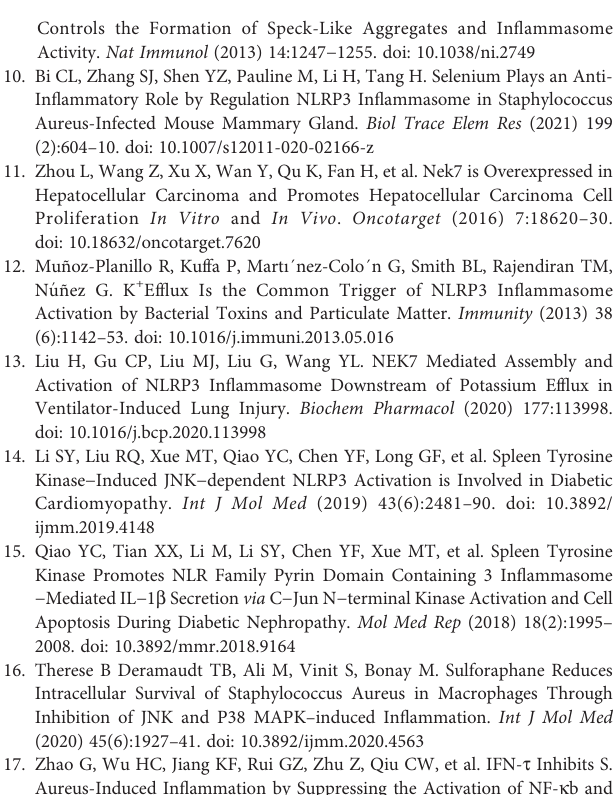
Supplementary Figure 1 | JNK and Syk activated the NLRP3 in fl ammasome upon S. aureus infection in PECs. PECs pretreated with or without JNK inhibitor at the fi nal concentration of 20 m mol/L or Syk inhibitor at the fi nal concentration of 1 m mol/L for 2 h followed by S. aureus infecton (MOI of 1) for 24 h. (A) The mRNA expression levels of caspase-1 , Il-1 b were quanti fi ed by RT-PCR. (B) The protein levels ofcaspase-1, p20, pro-IL-1 b andmIL-1 b wereexaminedby western blotand analyzed by relative densitometric quanti fi cation. (C) Immuno fl uorescence imaged endogenous ASC specks. Cells were fi xed and stained for ASC (Green), DAPI (Blue). (Scale bar: 100 µm.) (D) The mRNA expression levels of caspase-1 , Il-1 b were examined by RT-PCR. (E) The protein expression levels of caspase-1, p20, pro-IL-1 b and mIL-1 b were examined by western blot and analyzed by relative densitometric quanti fi cation. (F) The ASC specks formation were imaged via fl uorescence microscopy. (Scale bar: 100 µm.). Similar results were obtained in three independent experiments in data. Data shown are means ± SEMs; ** P < 0.01, **** P < 0.0001 vs. non-infection control group, # P < 0.05, ## P < 0.01, #### P < 0.0001 vs . infection control